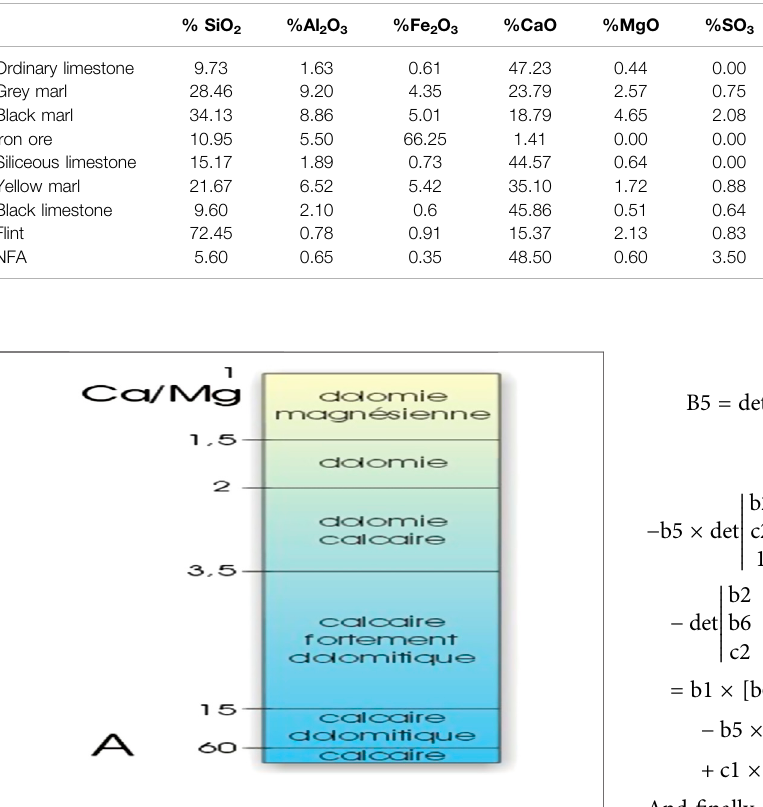
TABLE 4 | Chemical analysis of collected raw materials (in weight percentages).